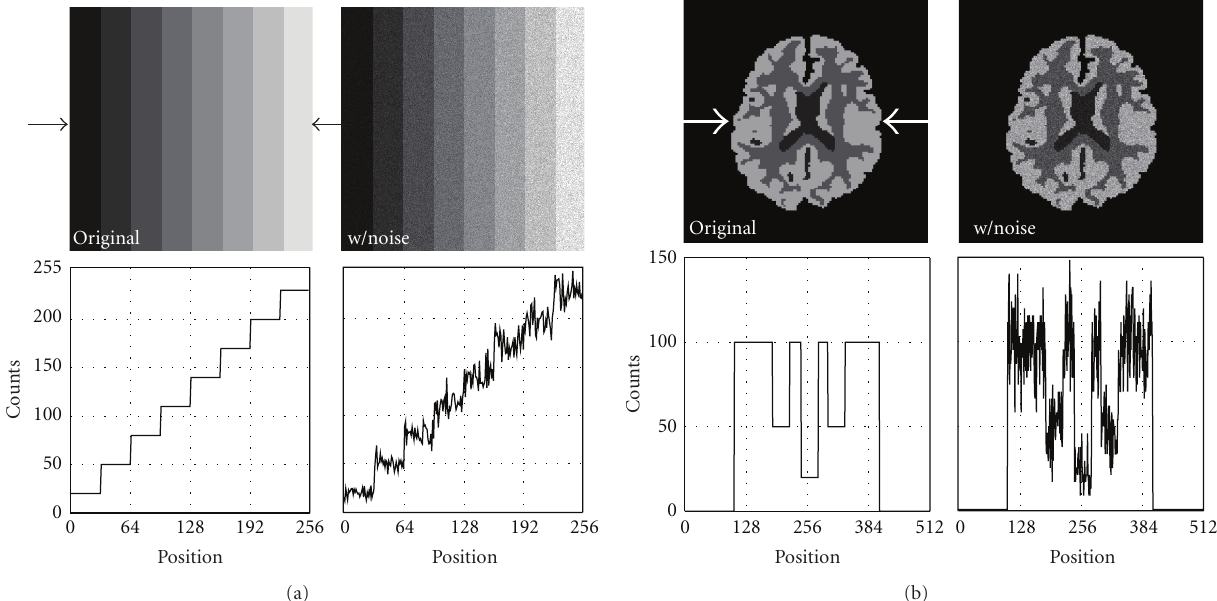
Figure 2: Original phantom images and those with Poisson noise. (a) Staircase phantom, (b) brain phantom. The profile along a line indicated with two arrows is shown below each